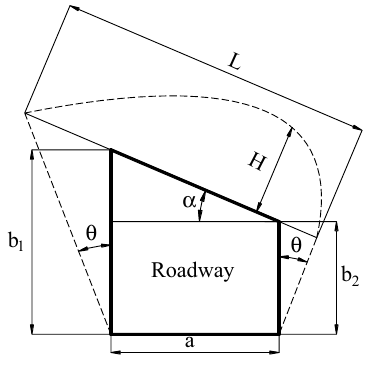
Figure 20. Loose ring of roadway